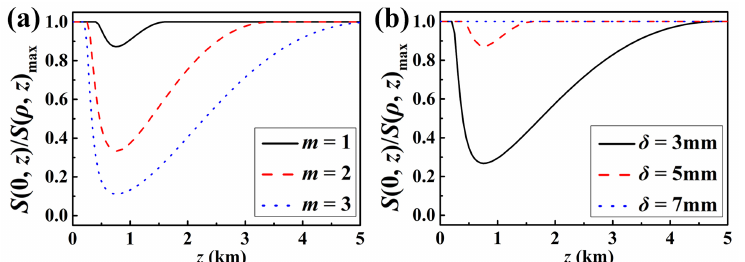
Figure 6. Ratio of the spectral intensity for the optical axis ( ρ = 0) against the maximum intensity in the transverse plane for the SSS beams traversing through oceanic turbulence for various ( a ) beam orders and ( b ) coherence